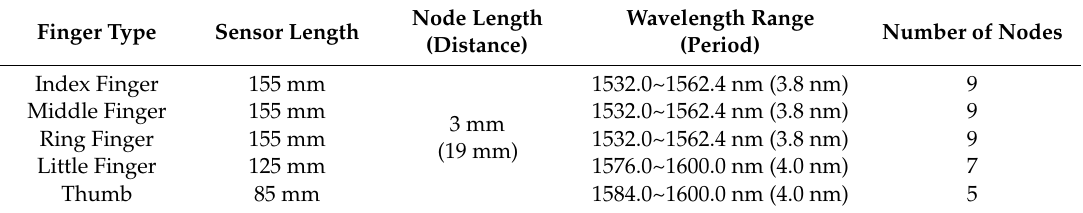
Table 1. Specifications of the FBG sensors comprising the wearable hand